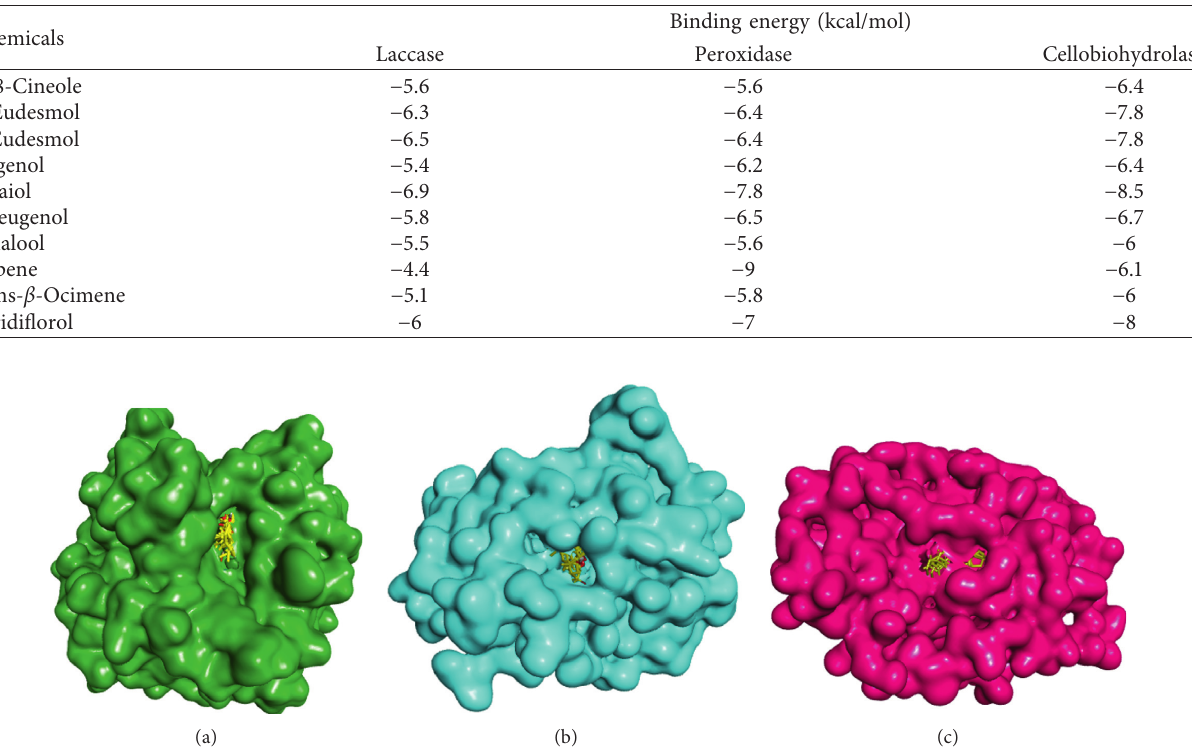
Figure 5: The overlaid positions of 10 chemicals into the pocket site of (a) cellobiohydrolase, (b) laccase, and (c) peroxidase. The proteins are presented as the surface form, and the ligands are presented as sticks from inside the proteins; yellow color represents carbon, red color represents oxygen, and white color represents